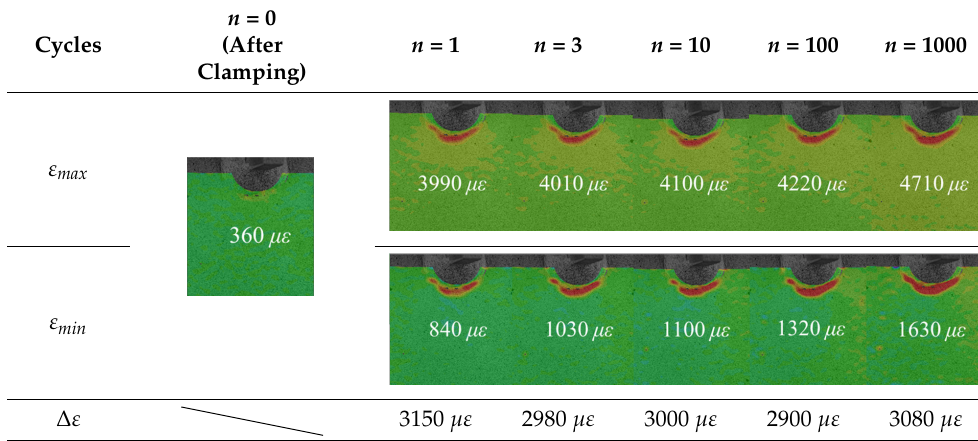
Table 1. Strain distribution measured by the proposed method (Specimen